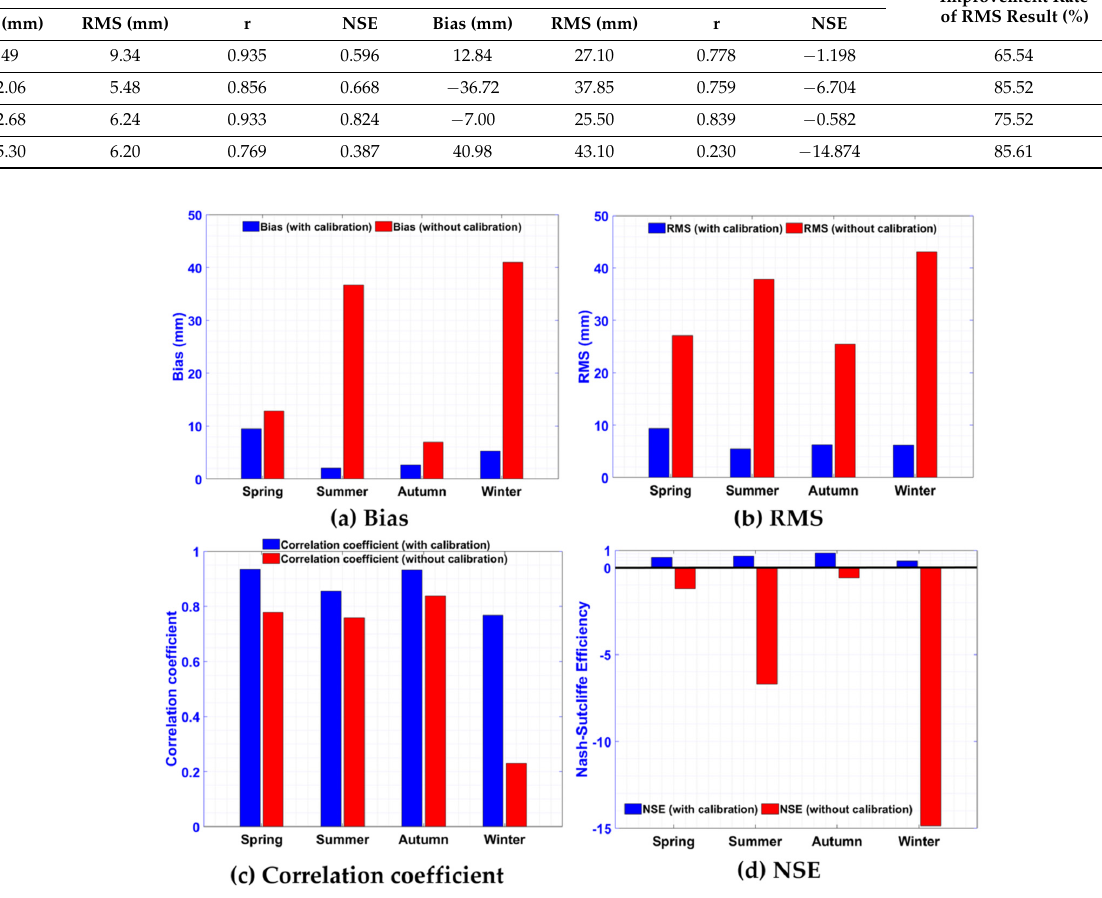
Figure 2. Seasonal bias ( a ), root mean square (RMS) error ( b ), correlation coefficient ( c ), and Nash Sutcliffe efficiency (NSE) results ( d ) of TH-PETs estimated under the situations of with (blue) and without (red) calibration process. Table 4. Comparison of the average seasonal differences between potential evapotranspiration (PET) time series estimated from the Penman–Monteith (PM) and Thornthwaite (TH) models at the three pairs of stations under the conditions of with and without calibration over the period 2008– 2019.